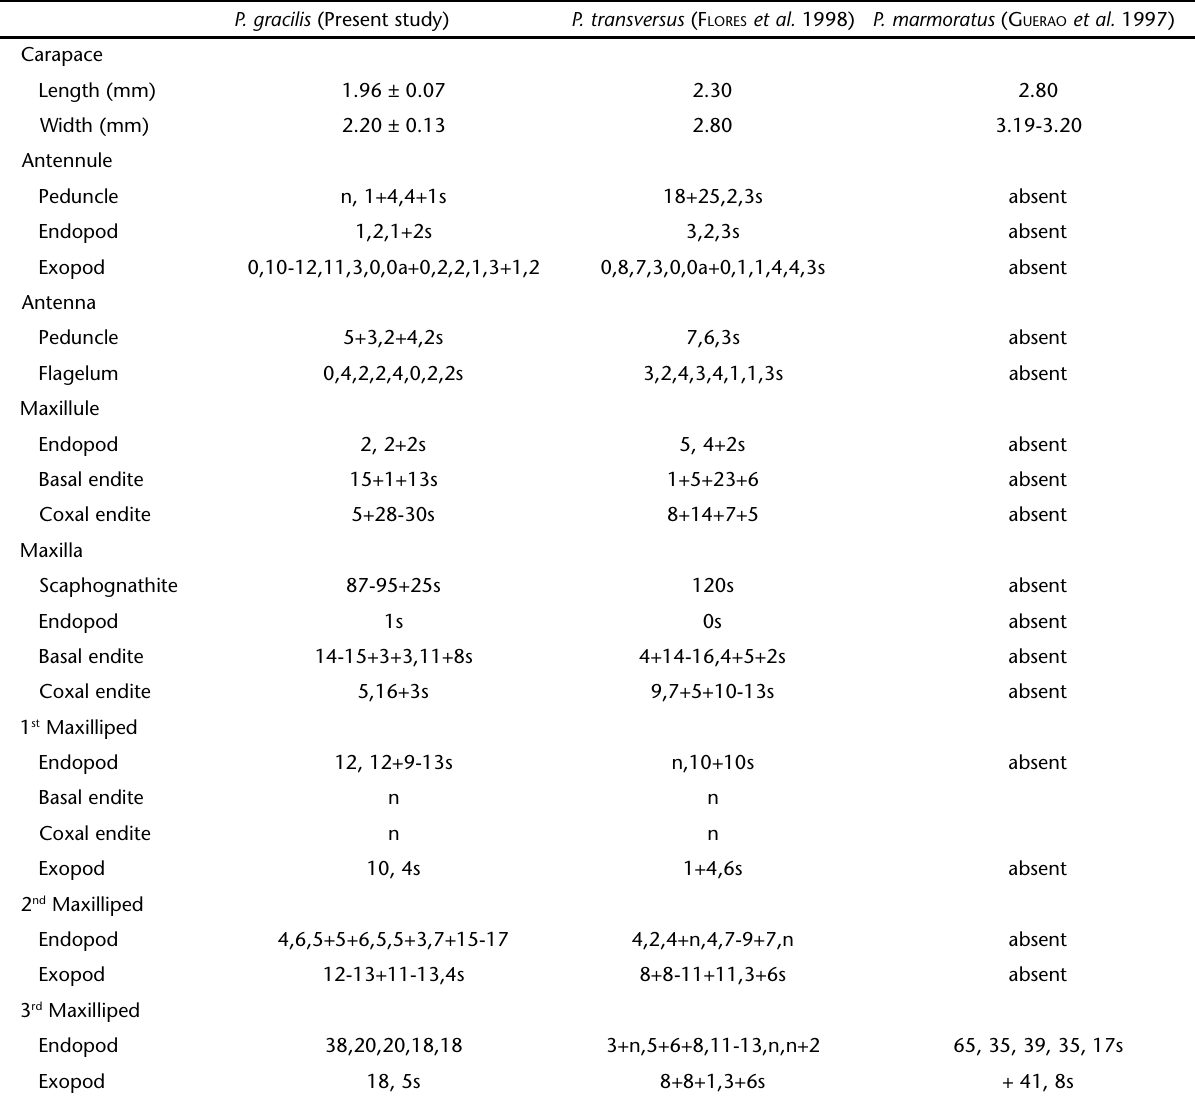
Table II. Morphological comparisons among juvenile I of some Pachygrapsus species. (s) Setae, (a ) aesthetascs, (sp) spine, (n) numerous setae, (ns) numerous setae in all segments. P. gracilis (Present